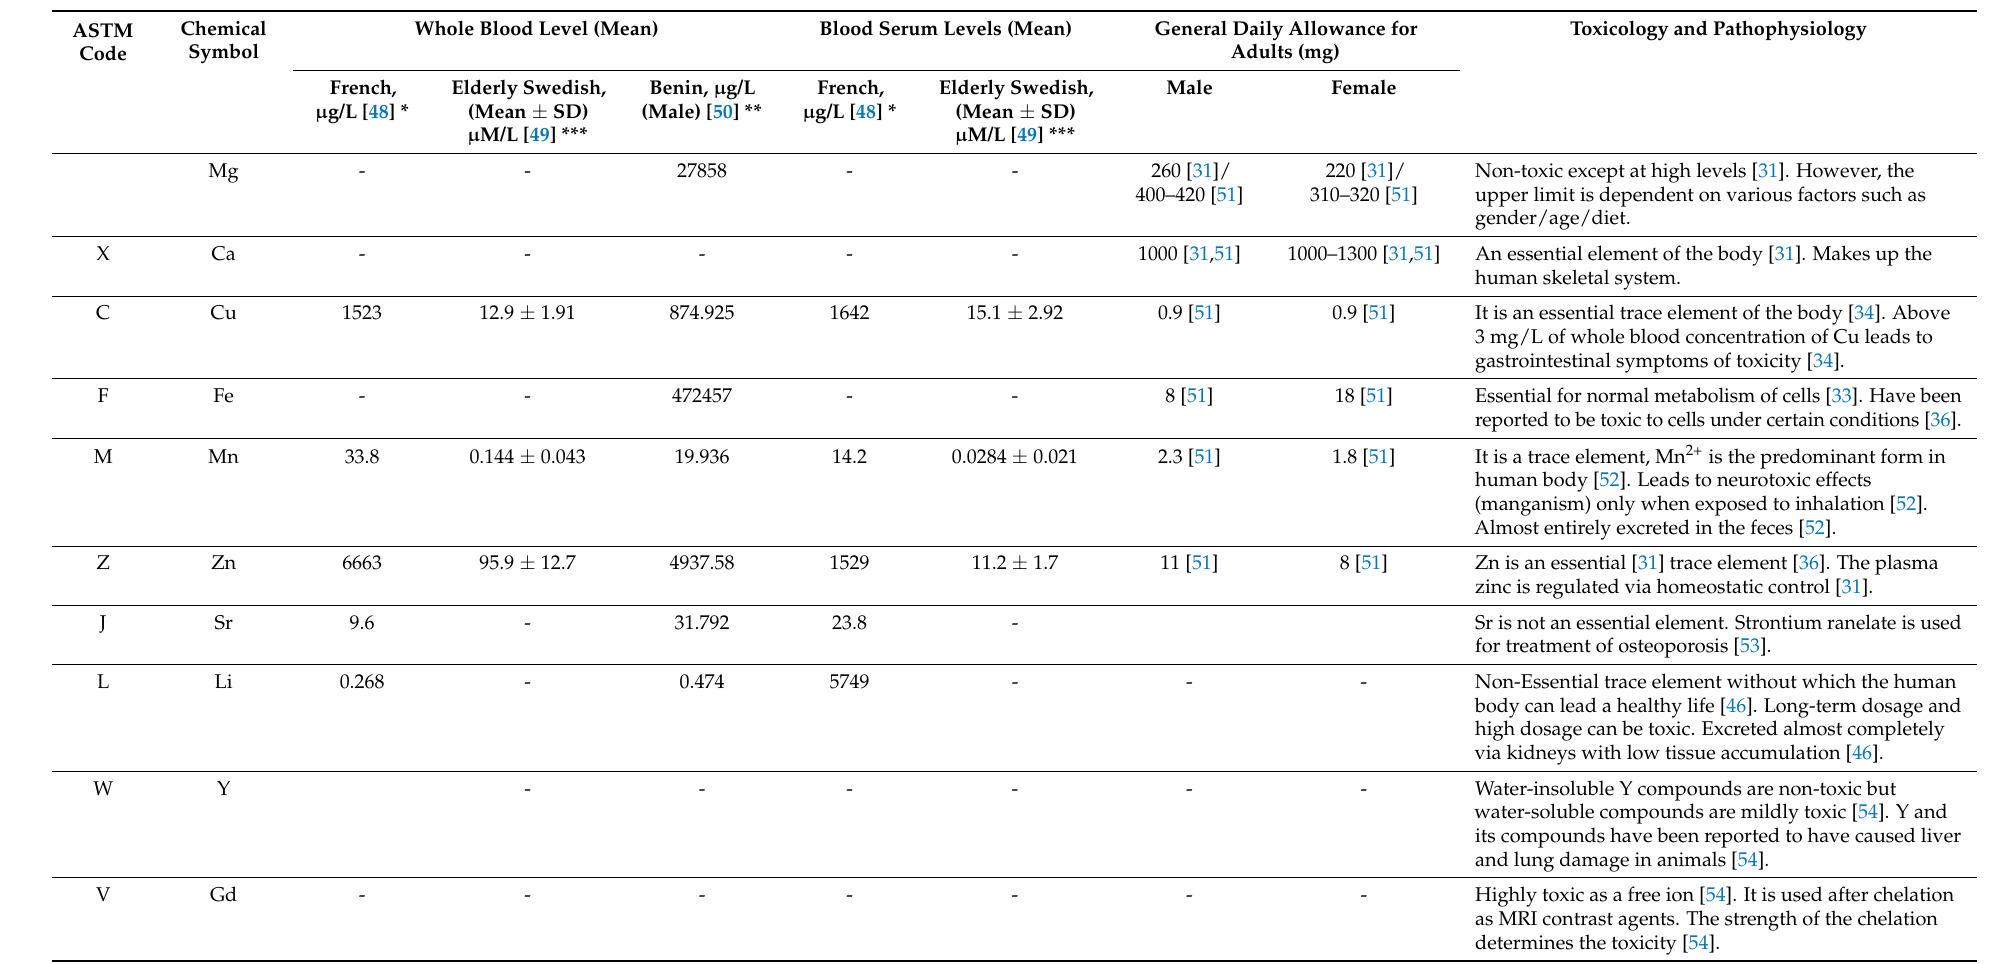
Table 1. Summary of toxicology of the common Mg alloying